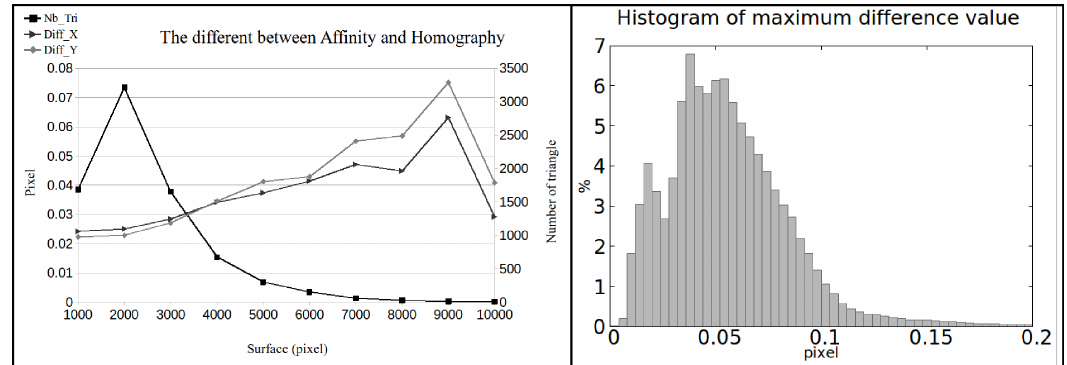
Figure 4. ( Left ): The difference of predicted pixel coordinate between affine and homography transformation in triangle. ( Right ): histogram of maximum difference value in the range of [0,0.2] pixel.